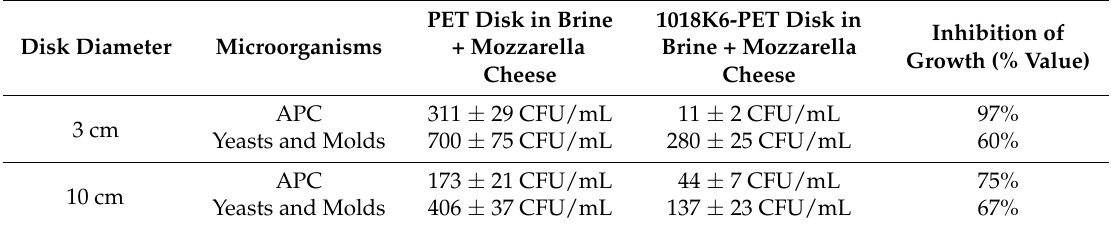
Table 1. Effects of 1018K6-PETs treatment on mozzarella